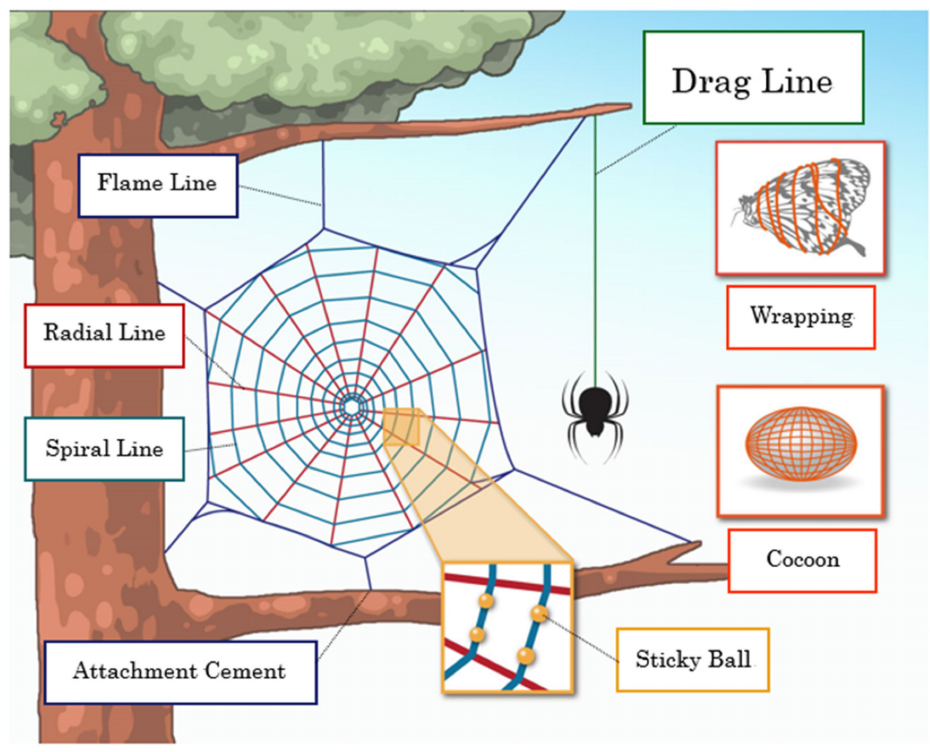
Figure 1. Schematic overview of seven types of spider